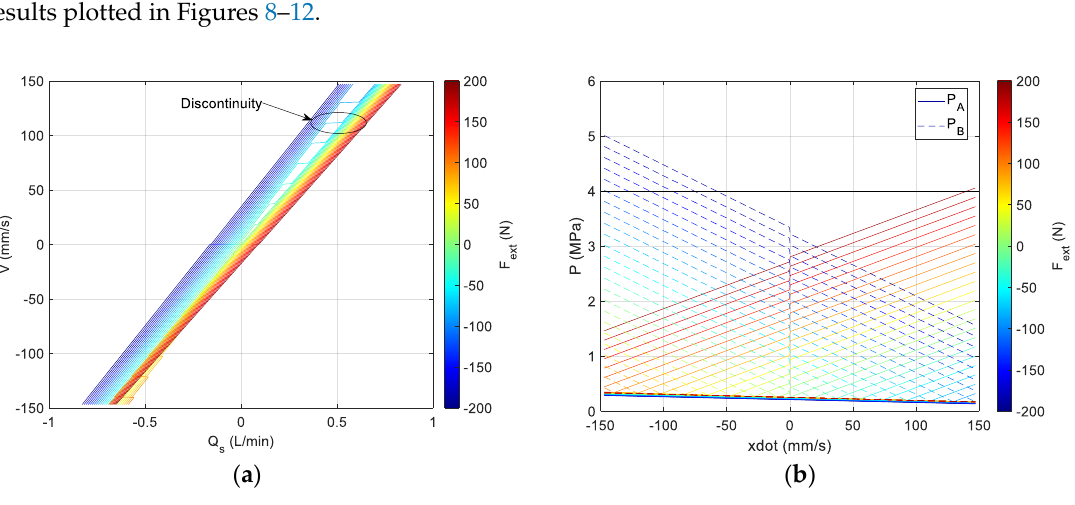
Figure 8. Calculated steady state model results for Valve A (steel sleeve and spool): ( a ) actuator velocity with respect to commanded pump flow and external force. Note the labelled discontinuity in velocity; ( b ) pressures with respect to actuator velocity and external force, including the 4 MPa pressure limit and 0.25 MPa charge pressure.